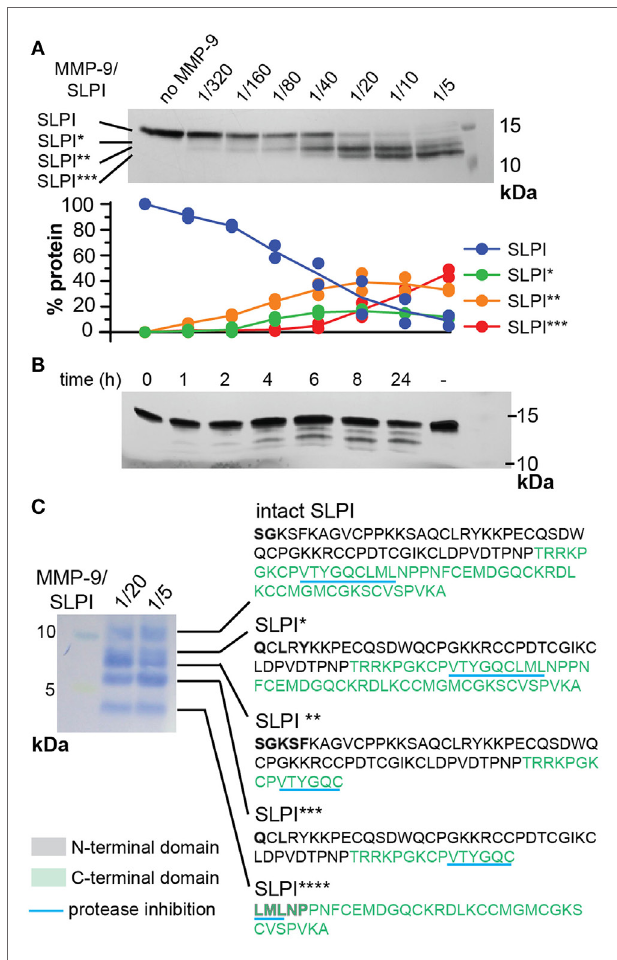
FigUre 2 | Cleavage of human secretory leukocyte peptidase inhibitor (SLPI) by matrix metalloproteases (MMP-9). (a) ; Incubation of SLPI with increasing quantities of active MMP-9 for 24 h at 37°C. Aside intact SLPI, three SLPI fragments were visualized; SLPI*, SLPI**, and SLPI*** (top). Densitometry analysis (bottom) of two independent experiments illustrates the appearance of fragments in the following order: SLPI**, SLPI*, and SLPI***. Data expressed as percentage of total SLPI protein. (B) Time- dependent incubation of SLPI with active MMP-9 (molar ratio 1/20). (c) Protein staining after blot transfer to a solid support and N-terminal sequencing of SLPI fragments. After blotting of larger quantities of SLPI, four cleavage fragments (SLPI*–SLPI****) were visible. N-terminal sequencing analysis revealed the presence of two MMP-9 digestion sites, also indicated in Figure 1 . Amino acids retrieved by N-terminal sequencing are marked in bold. Amino acid color codes correspond with the N-terminal and C-terminal domains, as shown in Figure 1